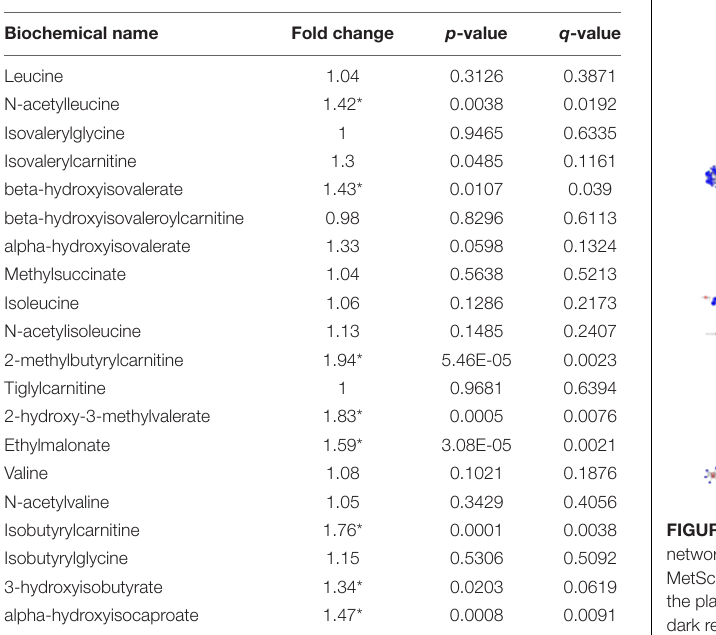
TABLE 4 | Branched chain amino acids are altered in LPS placenta.